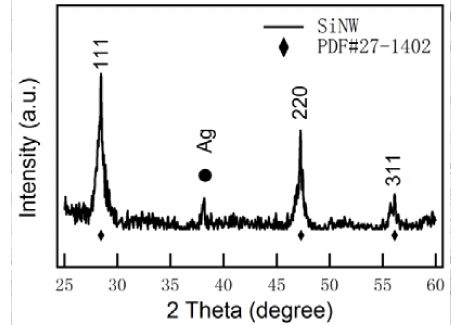
Figure 2. X-ray diffraction patterns of